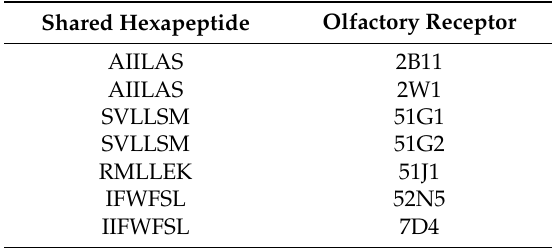
Table 4. Hexapeptide sharing between SARS-CoV-2 epitopes and olfactory